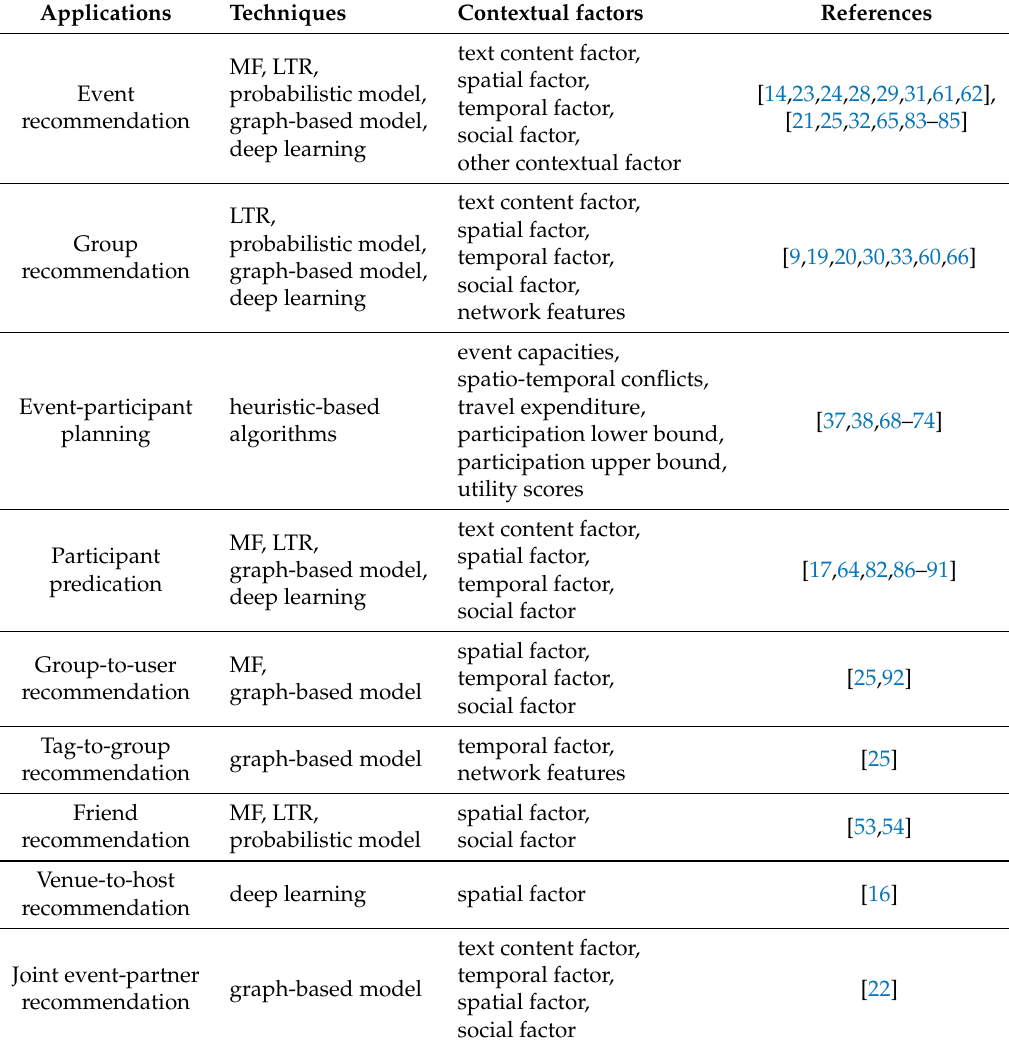
Table 4. Overview of applications of the context-aware recommendation in